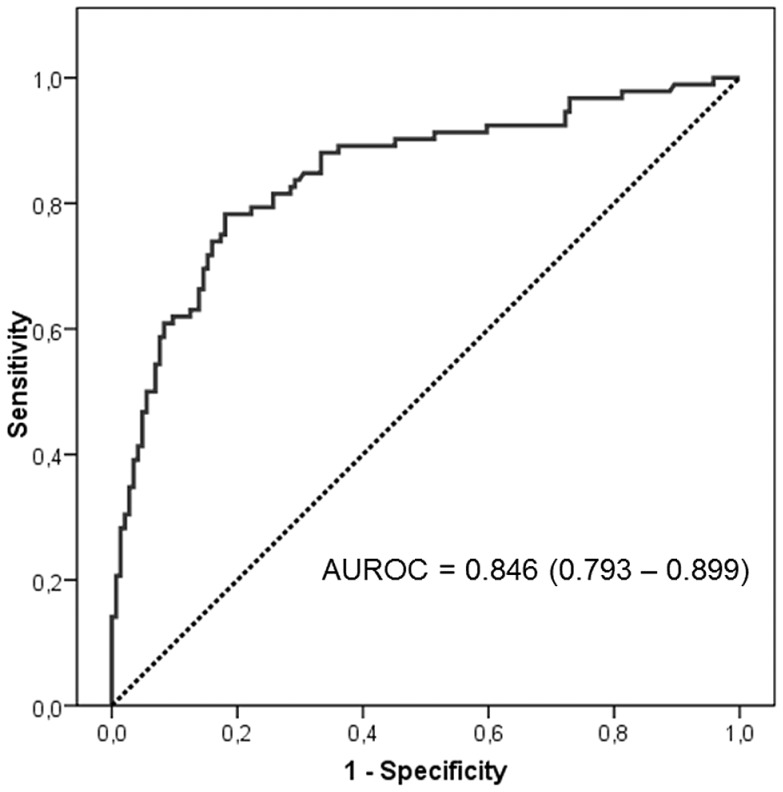
Receiver-operating curve provided by the model constructed to establish the predictive value for therapeutic failure.Area under the receiver-operating curve = 0.846 (95% confidence interval = 0.793–0.899).